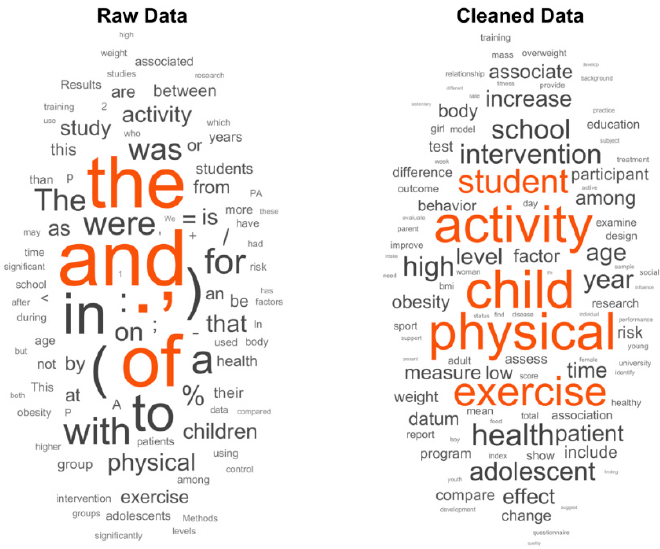
Figure 1. Main words found in the documents before and after